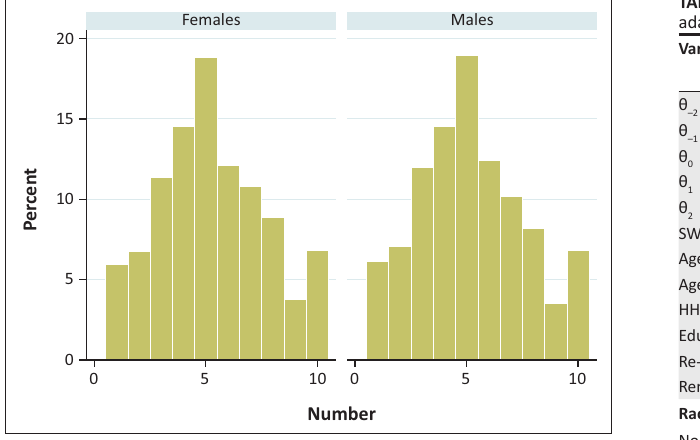
FIGURE 3: Subjective well-being by